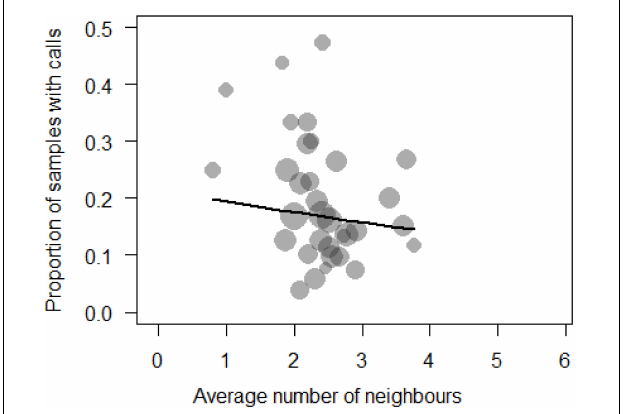
FIGURE 2 | Probability of call production by a focal animal expressed as a function of the number of neighbours within 10 m (Circle sizes are proportional to the number of samples per individual).